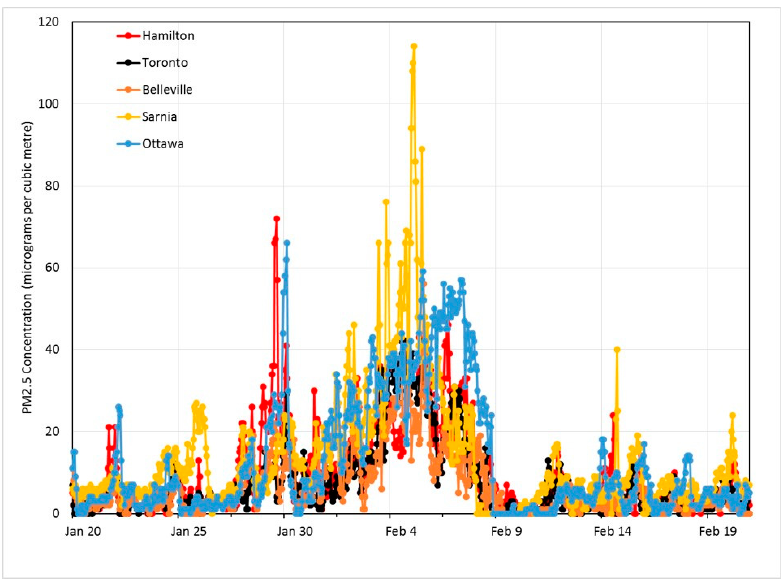
Figure 8. Daily maximum 1-h PM2.5 concentrations, 20 January–20 February 2005.